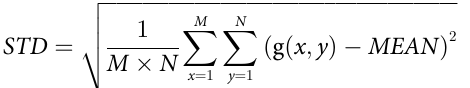
4.3.7 Image standard deviation (STD). The image gray standard deviation reflects the degree of dispersion between the image pixel value and the image average. The larger the stan- dard deviation, the better the image quality. The calculation formula of the image gray stan- dard deviation is as follows: